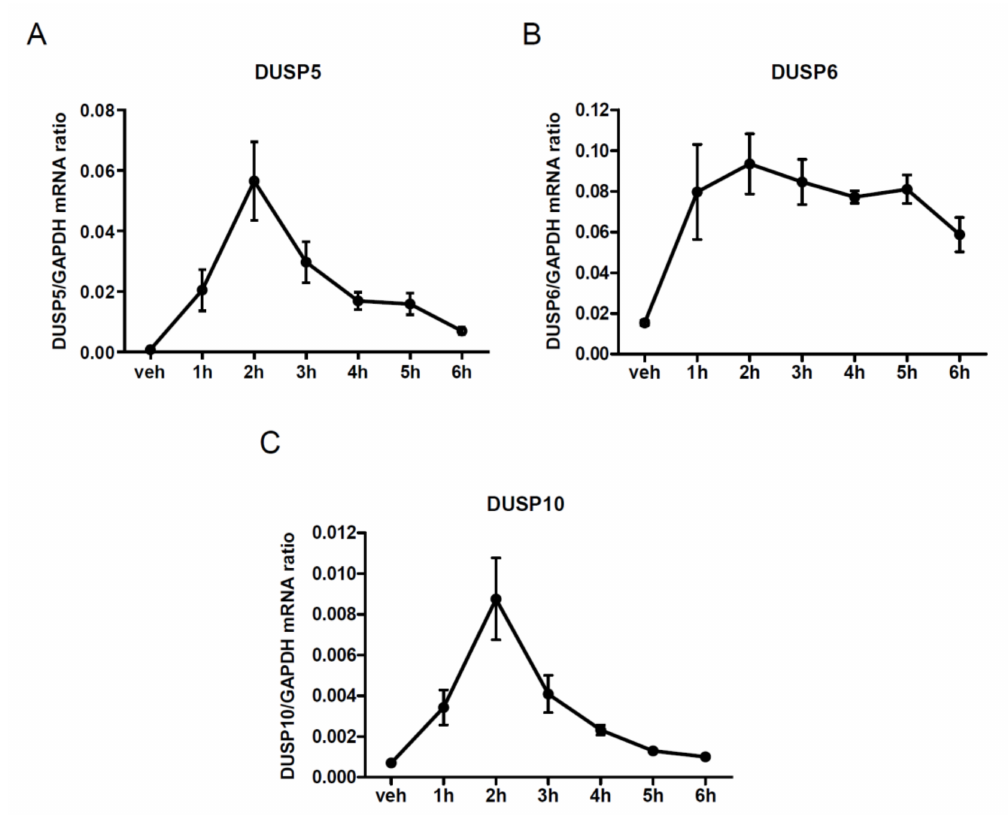
Figure 2. Time-dependent effect of AngII stimulation on gene expression in VSMCs. VSMCs were serum-depleted for 24 h, then cells were treated for various lengths of time intervals with 100 nM AngII, beside a control group treated with the vehicle. Time kinetics of ( A ) DUSP5, ( B ) DUSP6, and ( C ) DUSP10 expression levels are shown. The mRNA abundance was calculated via normalization to the GAPDH housekeeping gene and measured using real-time PCR. Mean values ± SE are shown ( n =